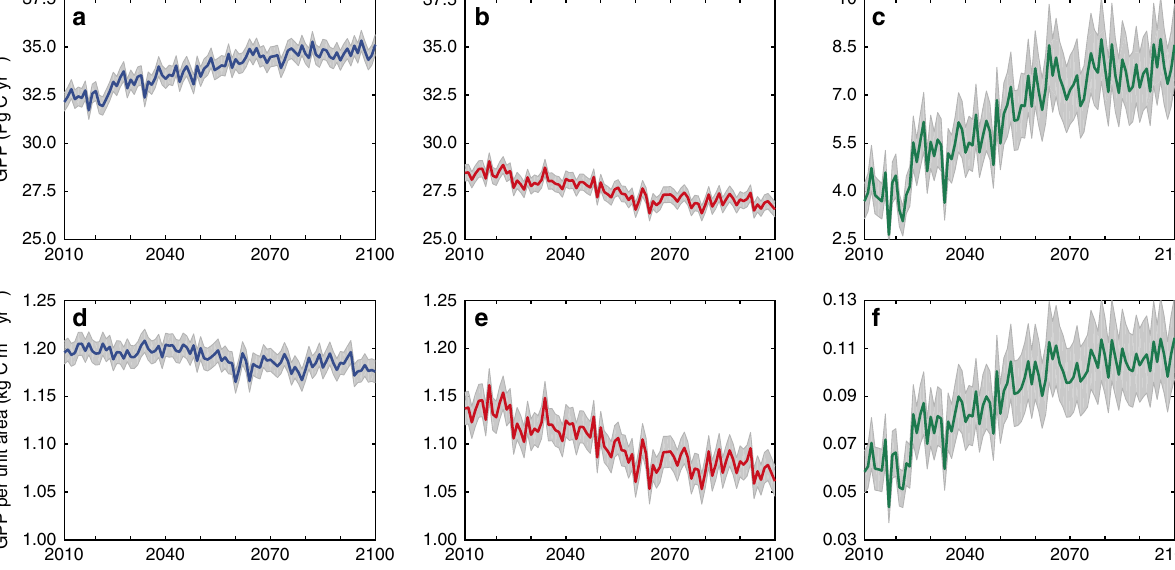
Fig. 6 Temporal variations in dryland GPP under RCP4.5 (2010 – 2100). a Temporal variations in the total GPP of the global drylands, including both